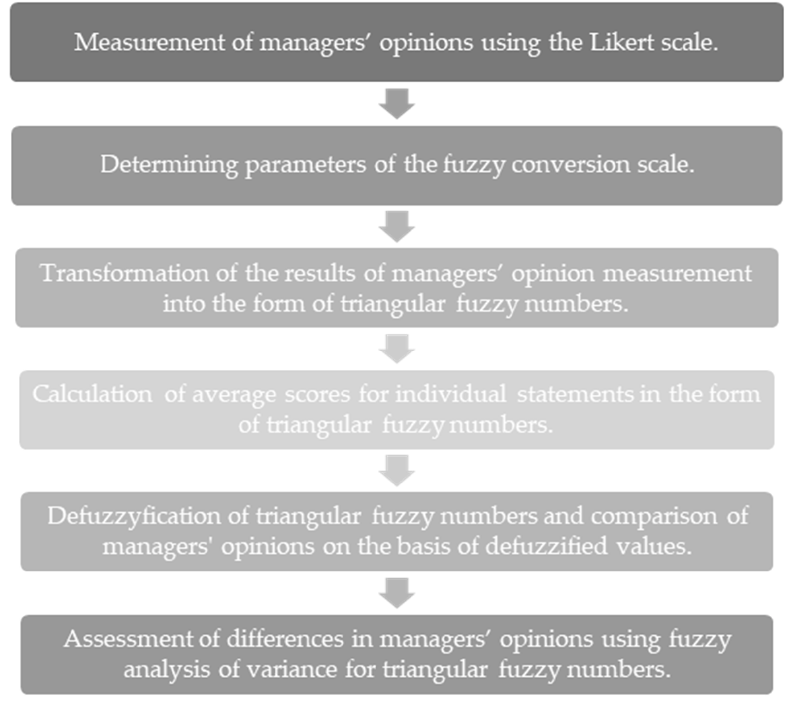
Figure 6. Total research flow chart.